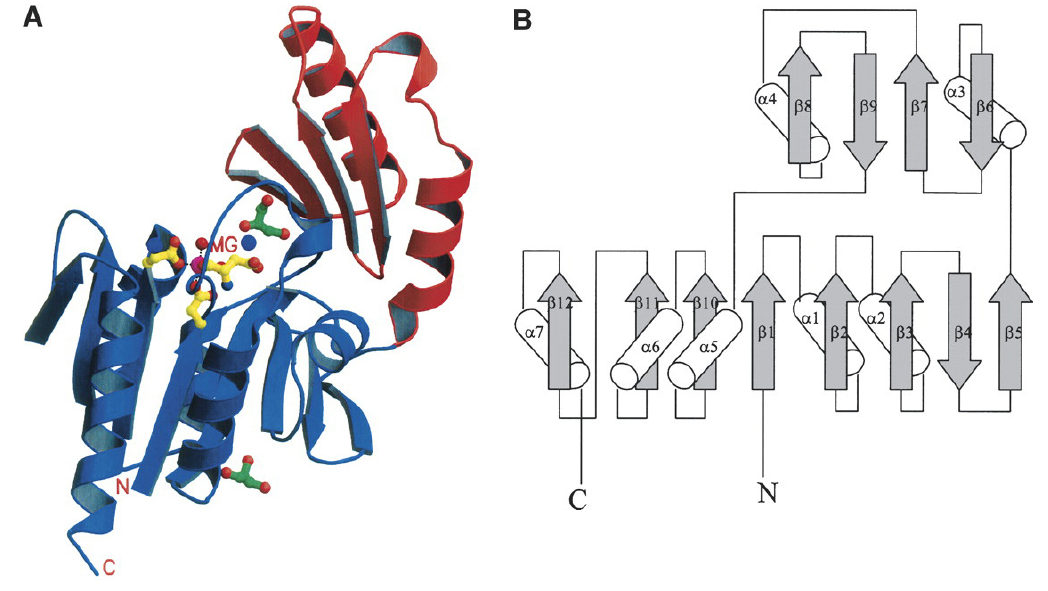
Figure 6. Crystal structure of trehalose-6-phosphate phosphatase provided by Rao et al . [188]. (A) Ribbon representation of structure of the enzyme (hydrolase domain, blue; cap domain, red). The magnesium ion (magenta), its coordinating residues (yellow), the two sodium ions (purple), and the two bound glycerol molecules (green) are shown in ball-and- stick model. (B) Topology diagram for the secondary structure of the enzyme (strands, arrows; helices, cylinders). Figure courtesy of Professor S. Swaminathan and Protein